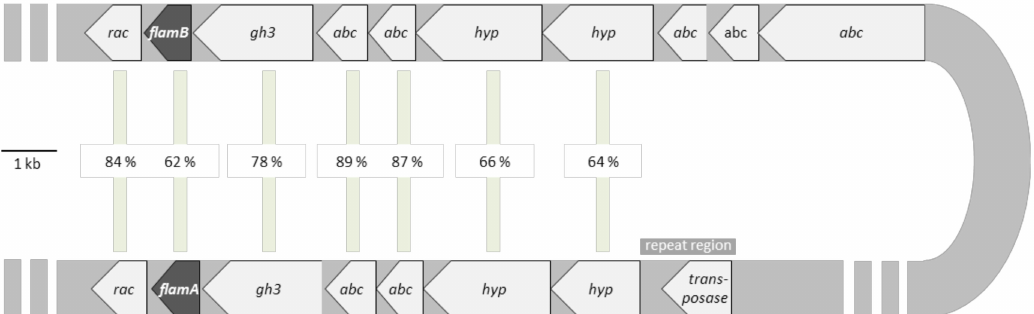
Figure 1. Predicted structural organization of the two operons containing flamA and flamB based on the highly similar genes in the genome of Fervidobacterium nodosum . Sequence identities of similar genes are shown in the center. Predicted genes: rac— putative gene for alanine racemase; flamA and flamB— genes for β -1,3-glucanases; gh3 —putative genes for glycoside hydrolase of family GH 3; abc —putative genes for ABC transporter proteins; transposase —truncated gene of a Transposase_20 with a repeat region; hyp —hypothetical